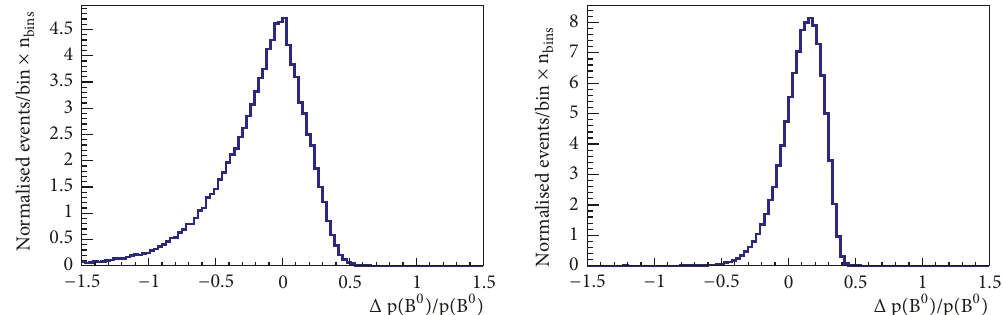
Figure 5: Relative resolution on the 𝐵 momentum magnitude for 𝐵 󳨀→ 𝐷 ∗+ 𝜏 − (󳨀→ 𝜋 + 𝜋 − 𝜋 − ] 𝜏 ) ] 𝜏 decays, obtained using (left) full reconstruction and (right) equal velocity algorithms.